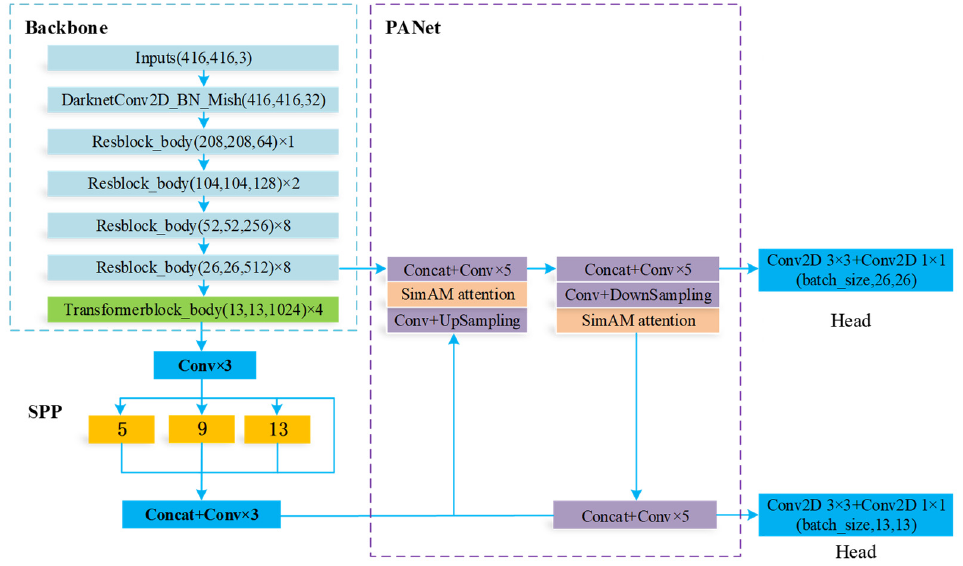
Figure 3. YOLO ‐ BS algorithm structure